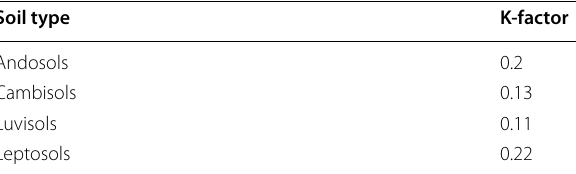
Table 1 Soil erodibility